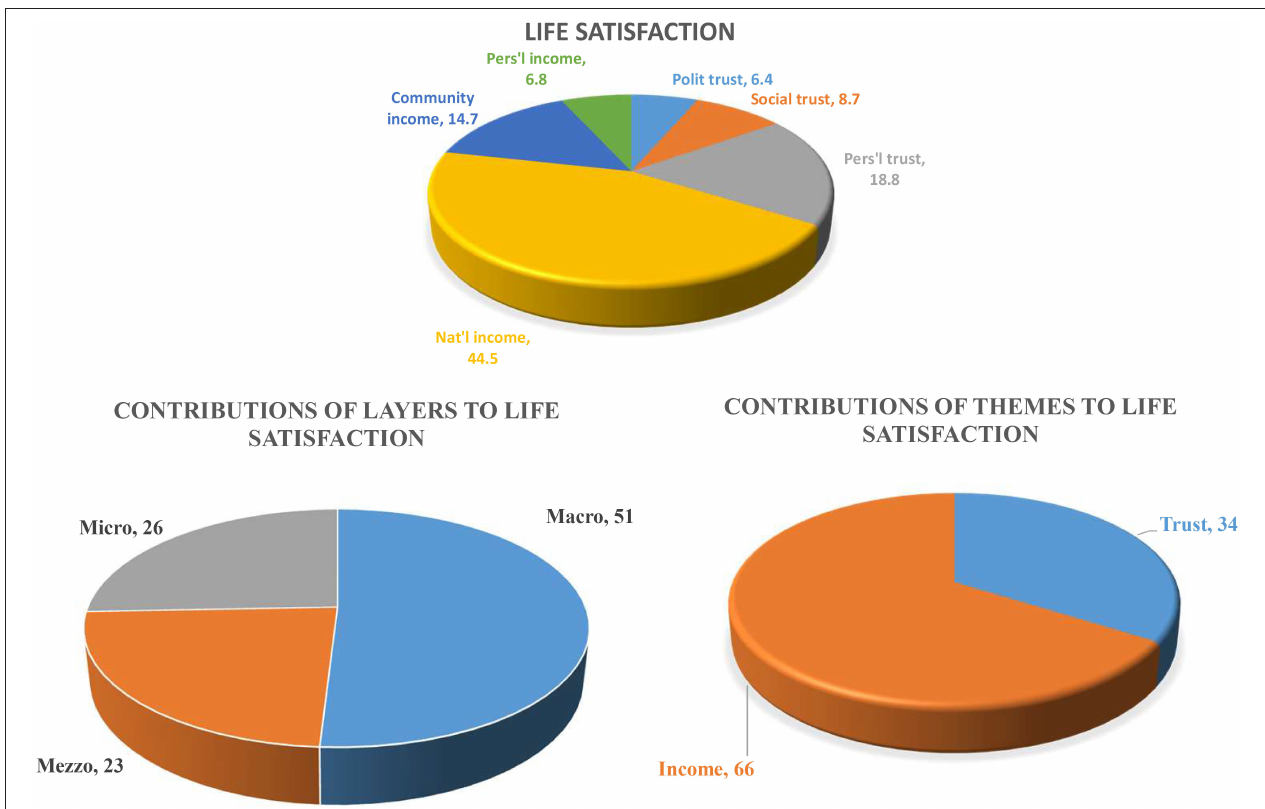
FIGURE 2 | Overview of the relative importance of personal, community, and national income; personal, social and political trust for life satisfaction, by layer and by theme. Results of multilevel analysis. Levels: individual, community, and country. Percent. Valid N (listwise) = 44,833. Micro level = Individual. Mezzo level